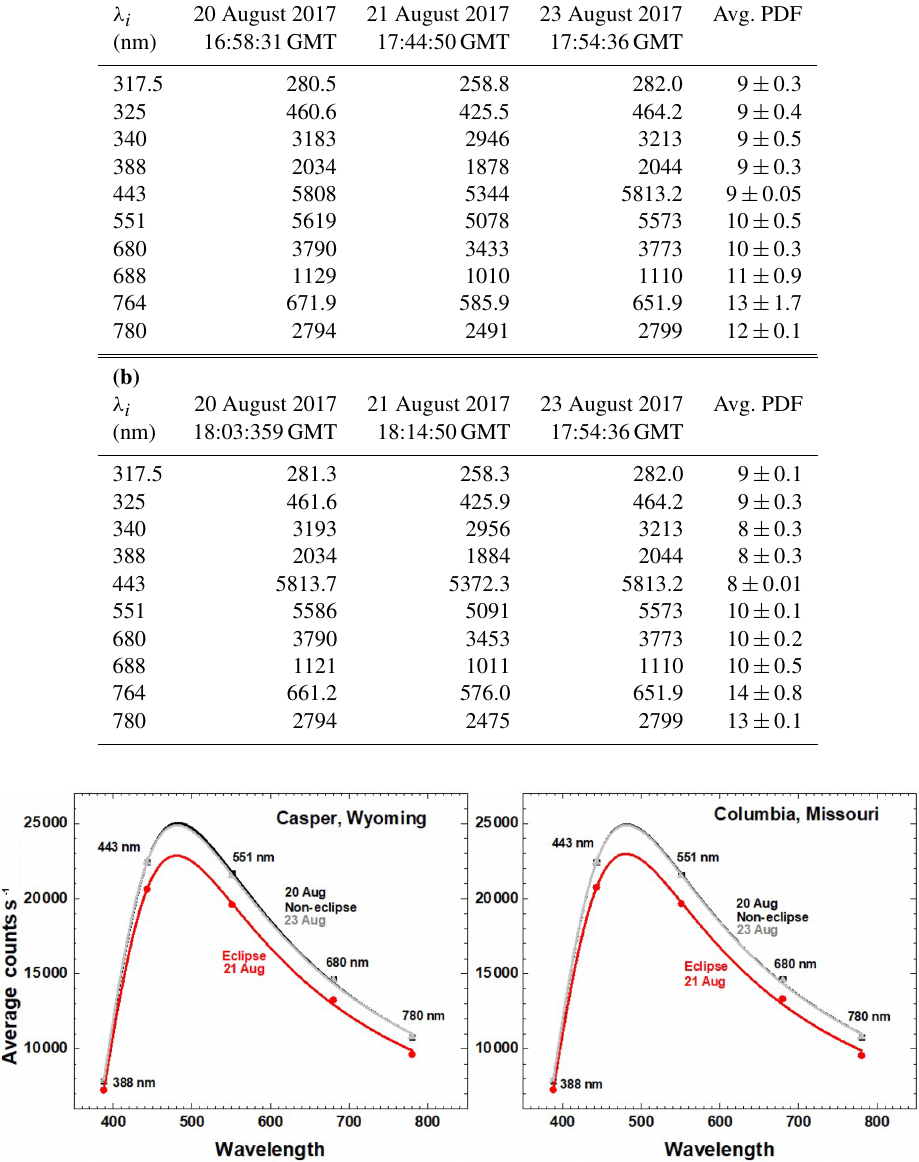
Figure 9. Average reflected light in counts per second for eclipse (21 August, red) and non-eclipse (20 and 23 August, black and gray) days from Table 3 and Eq. (1) for Casper and Columbia. The locations of the maxima are from curve fitting to the discrete wavelength